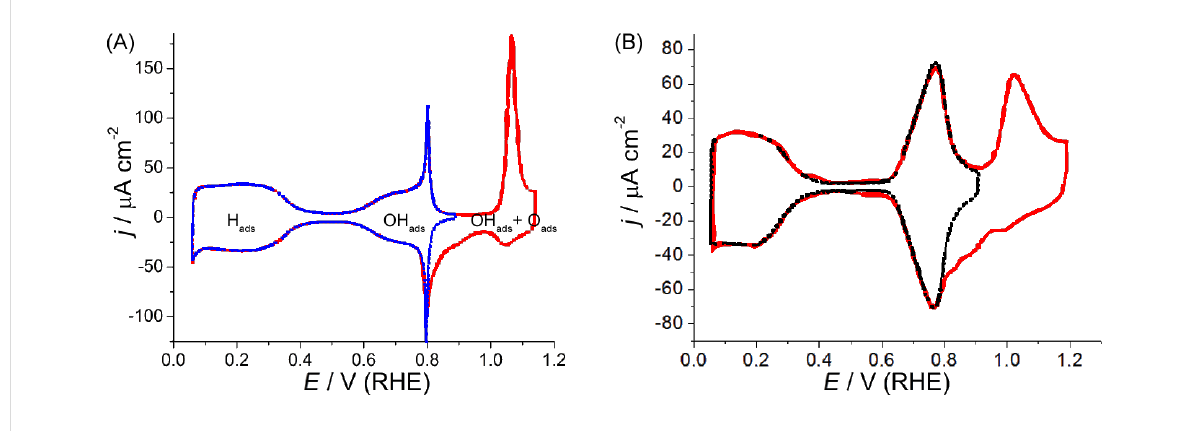
Figure 1: Stable voltammetric profile of a well-ordered Pt(111) electrode at 50 mV·s − 1 , at two upper potential limits: 0.9 V (blue or black) and 1.15 V (red) in 0.1 M: A. HClO 4 (left). B. NaOH (right).